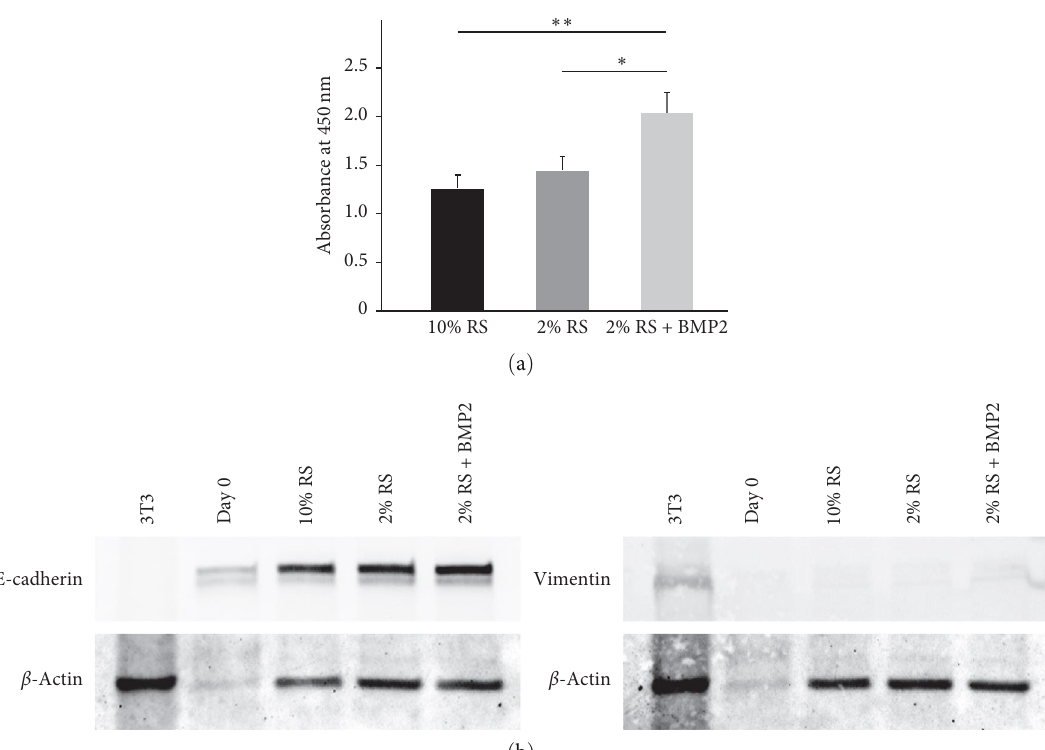
F IGURE 2: Mouse parotid acinar cells in primary culture. (a) Cell proliferative capacity of BMP2-added (100ng/mL) and nonadded (control) groups after 48 hr of culture. The proliferative capacity of BMP2-added cultured cells was signi fi cantly increased compared to that in the control group. ∗∗ Indicates signi fi cance at P < 0 : 01, ∗ P < 0 : 05. Data were shown as mean Æ SD. Three independent experiments were per- formed. (b) Protein expression of E-cadherin (an epithelial marker) and vimentin (a mesenchymal marker) in cultured cells of each group at 48hr after the addition of BMP2. NIH3T3 (3T3) was used as a positive control for mesenchymal markers. RS: rat